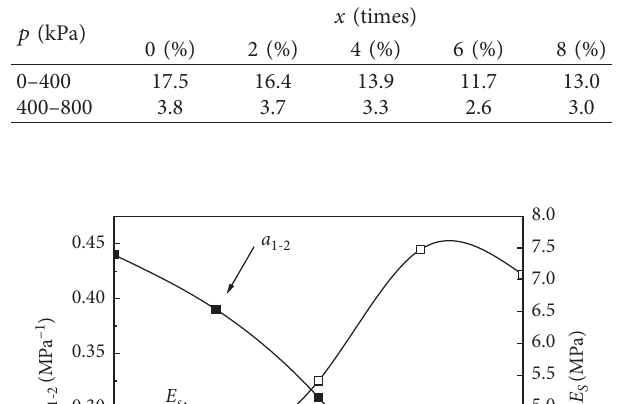
1-2 or E s and x .